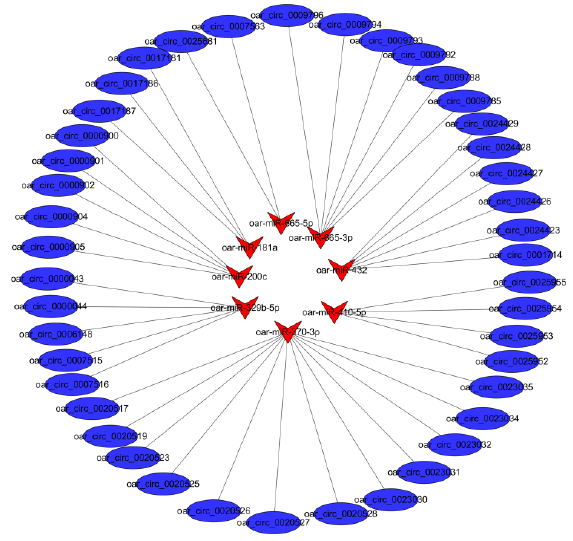
Figure 4. Regulatory networks of circRNA-miRNA interactions in the follicular phase. Triangular nodes represent miRNA, and circular nodes represent circRNA.